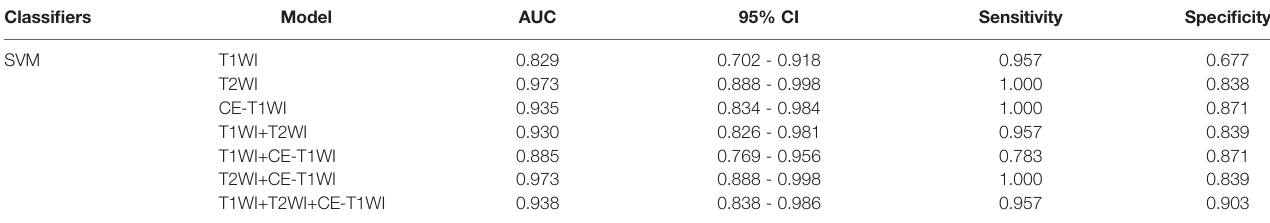
TABLE 9 | The ROC curve of different models of SVM-classi fi er in the training cohort. Classi fi ers